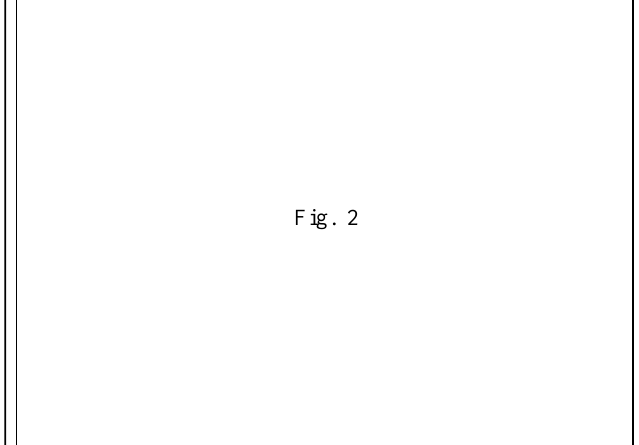
Fig.2: Epitheloid cell granuloma with Langerhans' giant cell